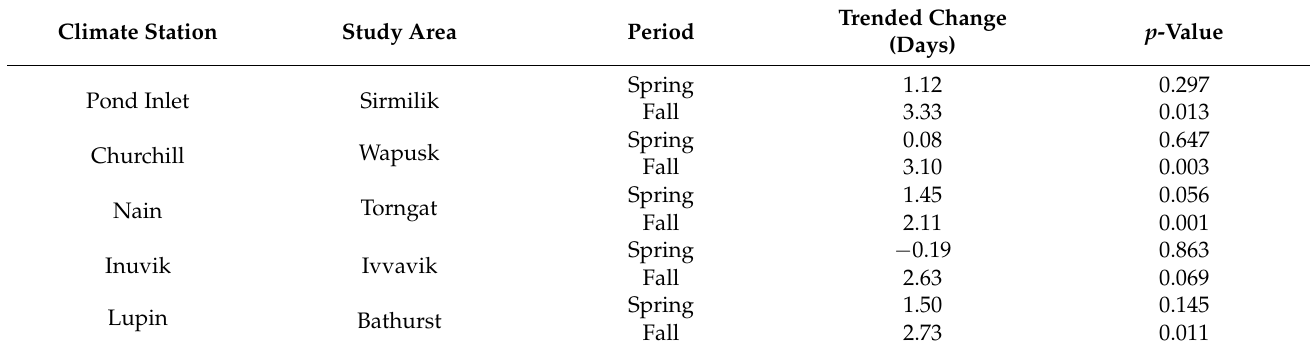
Table 3. Long term trends in spring (May and June) and fall (September and October) temperature at climate stations near the five study areas during 1985–2013. The trended change is the magnitude of change during 1985 and 2013, calculated as the value of the trend line in 2013—that in 1985.